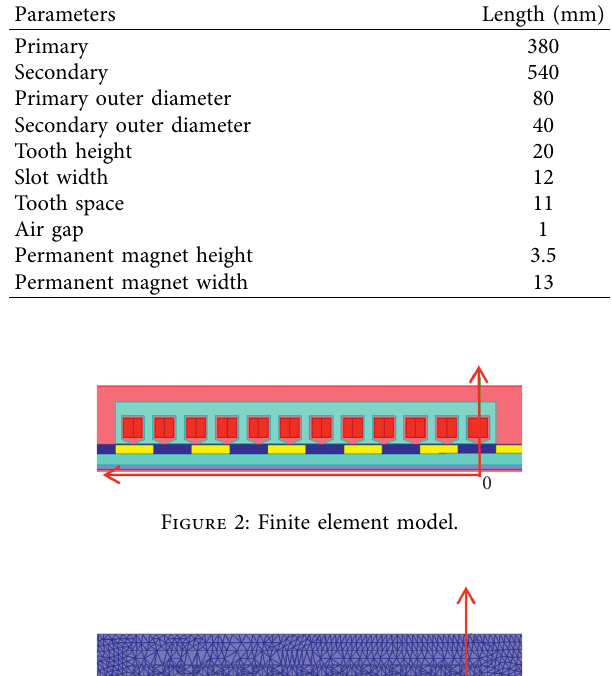
Figure 3: Mesh dividing model.